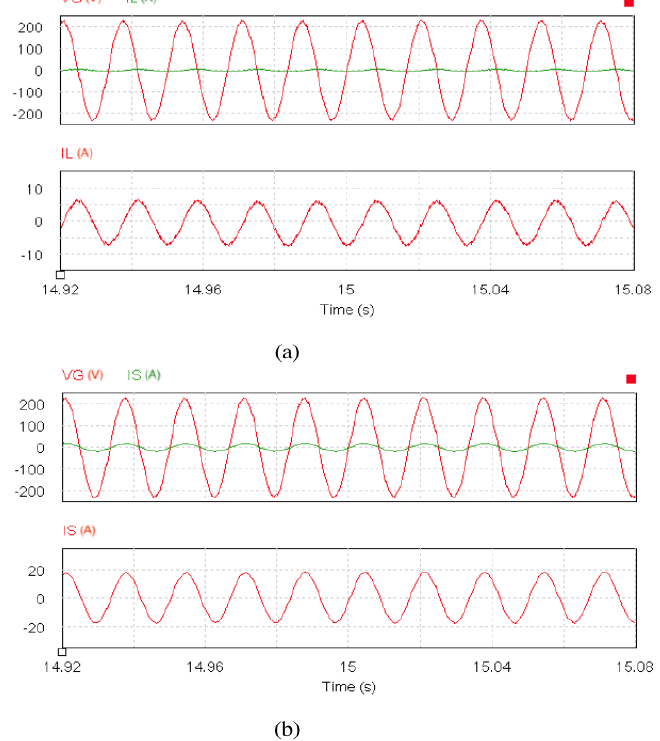
Figure 10. Simulation results in reactive power compensation mode: ( a ) The voltage and current waveforms at the output of inverter. ( b ) The voltage and current waveforms of the AC